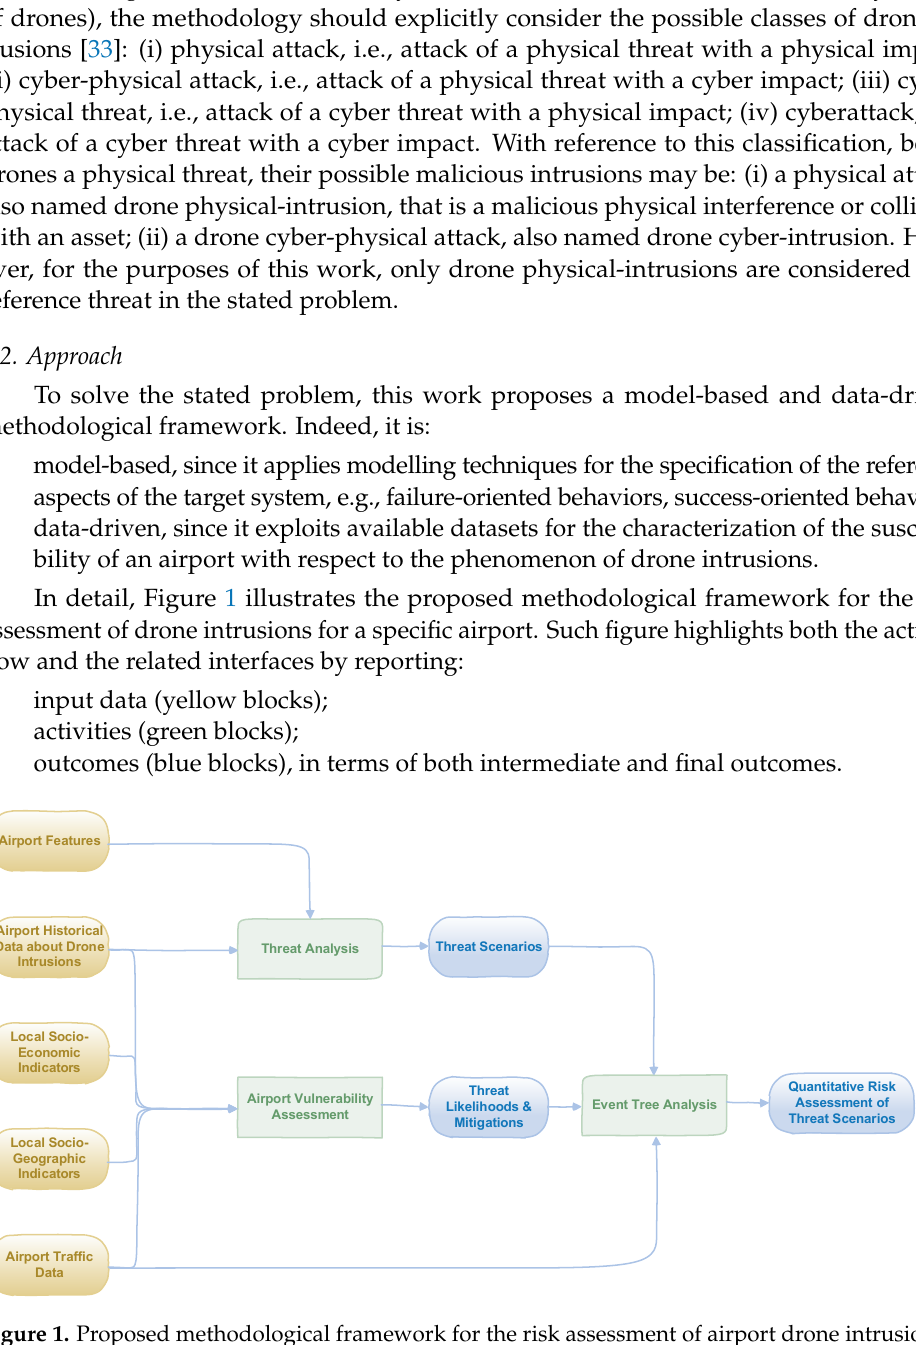
Figure 1. Proposed methodological framework for the risk assessment of airport drone intrusions.